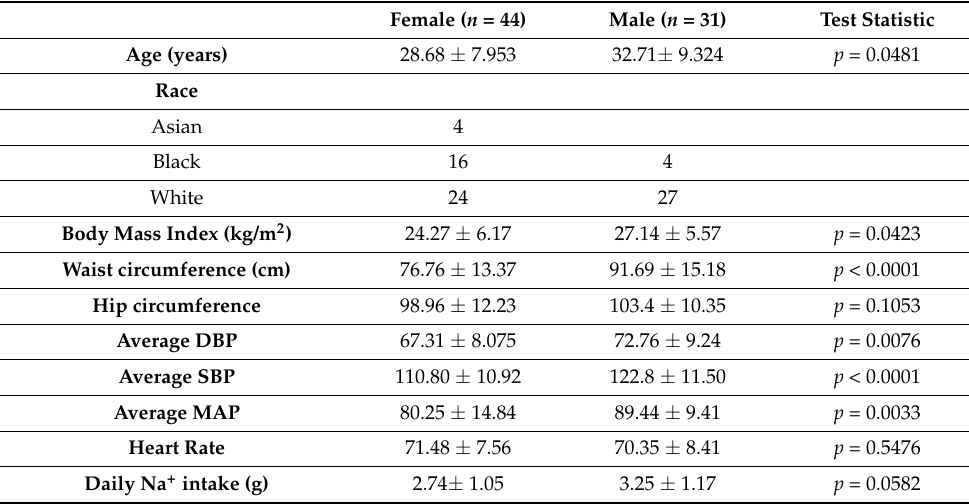
Figure 1. Relationship between a high-salt diet, sex differences and blood pressure. ( A ) Study design: self-reported short-term dietary Na + intake was estimated from 3-day food records before the study visit. Metabolomic analysis was performed on plasma and fecal samples. ( B ) Diastolic pressure relationship with dietary Na + intake. ( C ) Systolic pressure relationship with dietary Na + intake. ( D ) Mean arterial pressure relationship with dietary Na + intake in men ( n = 31) and women ( n = 44). Blue symbols represent men. Pink symbols represent women. Table 1. Demographic and clinical characteristics of the subjects by short-term sodium intake.